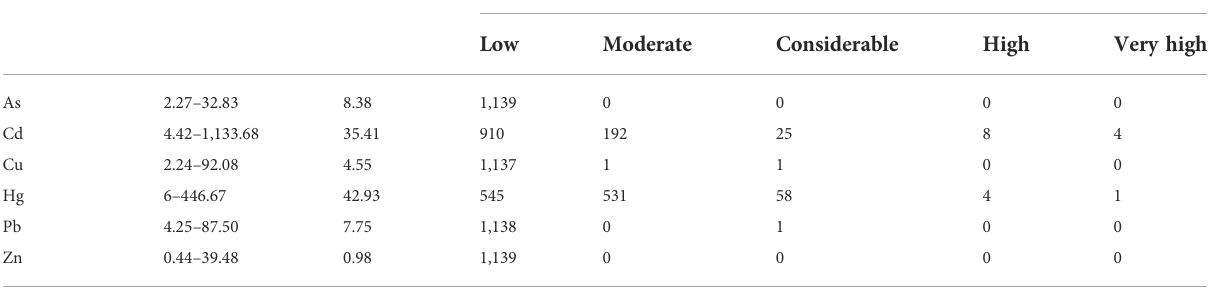
TABLE 4 Evaluation results of potential ecological risk factors ( E i -values) for heavy metals in soil. Element Range Mean The proportion of sample sites with different risk levels (number of samples) Low Moderate Considerable High Very high